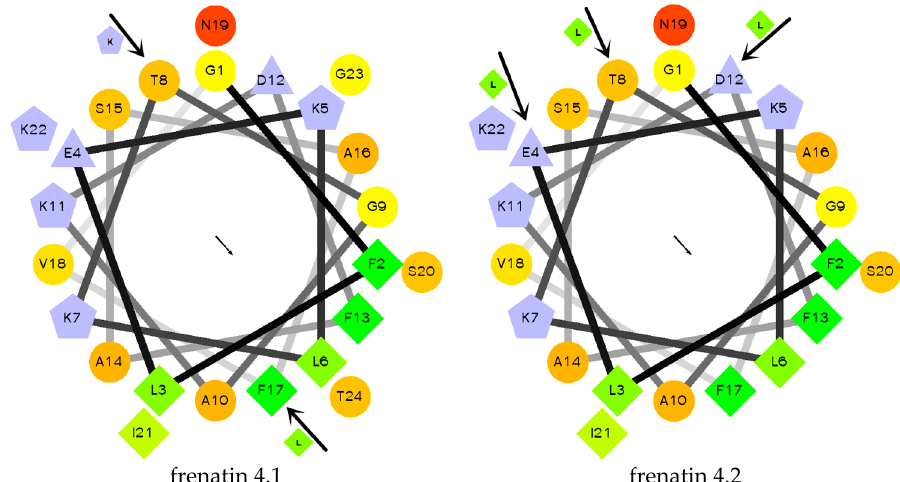
Figure 5. Helical wheel projections of frenatin 4.1, frenatin 4.2 and amino acid residue substitutions of their analogues. The directions of hydrophobic moments of the parent peptides are denoted by the arrows in the middle of the wheels. The amino acid residue substitutions are also indicated. Table 1. Physicochemical properties of frenatin peptides and their analogues. Peptide H μ H Net Charge (z)